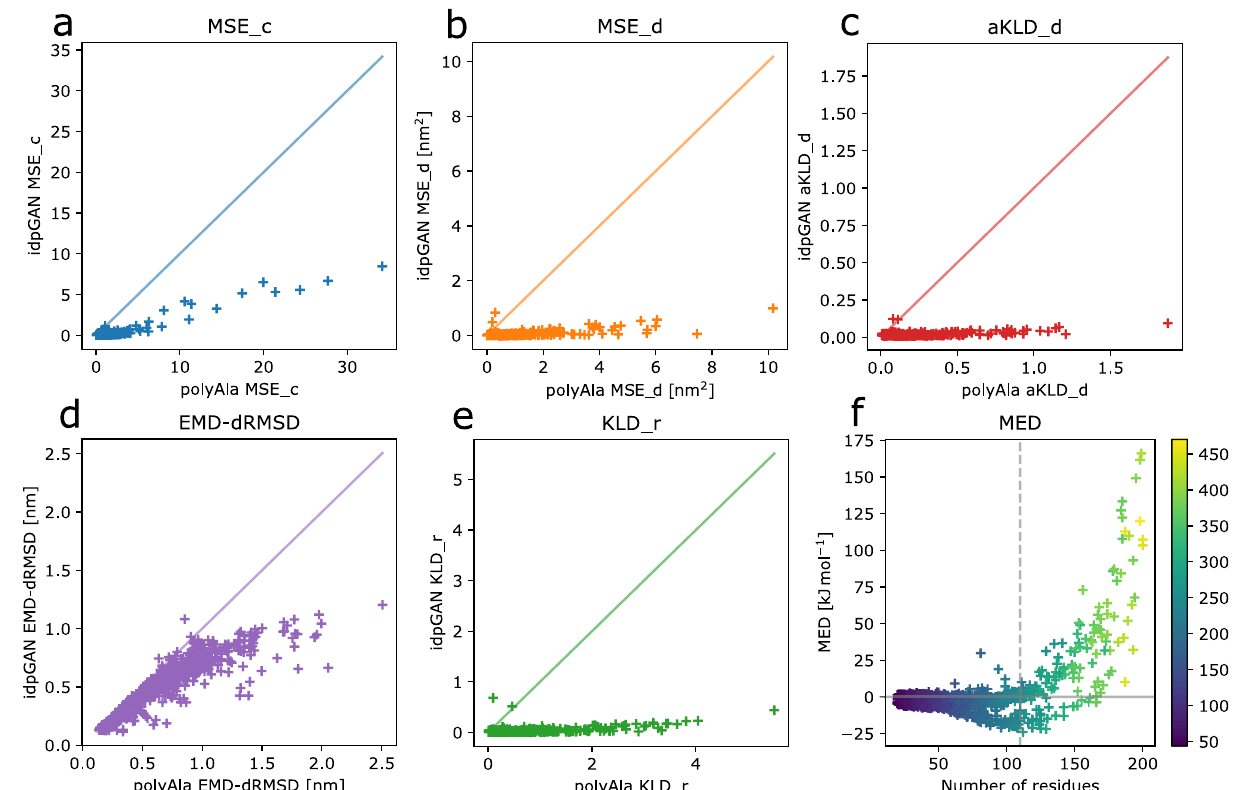
Fig. 5 | Evaluation of idpGAN and polyAla ensembles for approximating MD data. ResultsarereportedforHB_valsetprotein( n =1021). a , b , c , d ,and e showthe valuesofMSE_c,MSE_d,aKLD_d,EMD-dRMSDandKLD_r,respectively,obtainedby polyAla(x-axis)andidpGAN(y-axis)foralltheproteinsintheset.See “ Methods ” for a description of the metrics. Lower values indicate better performance in